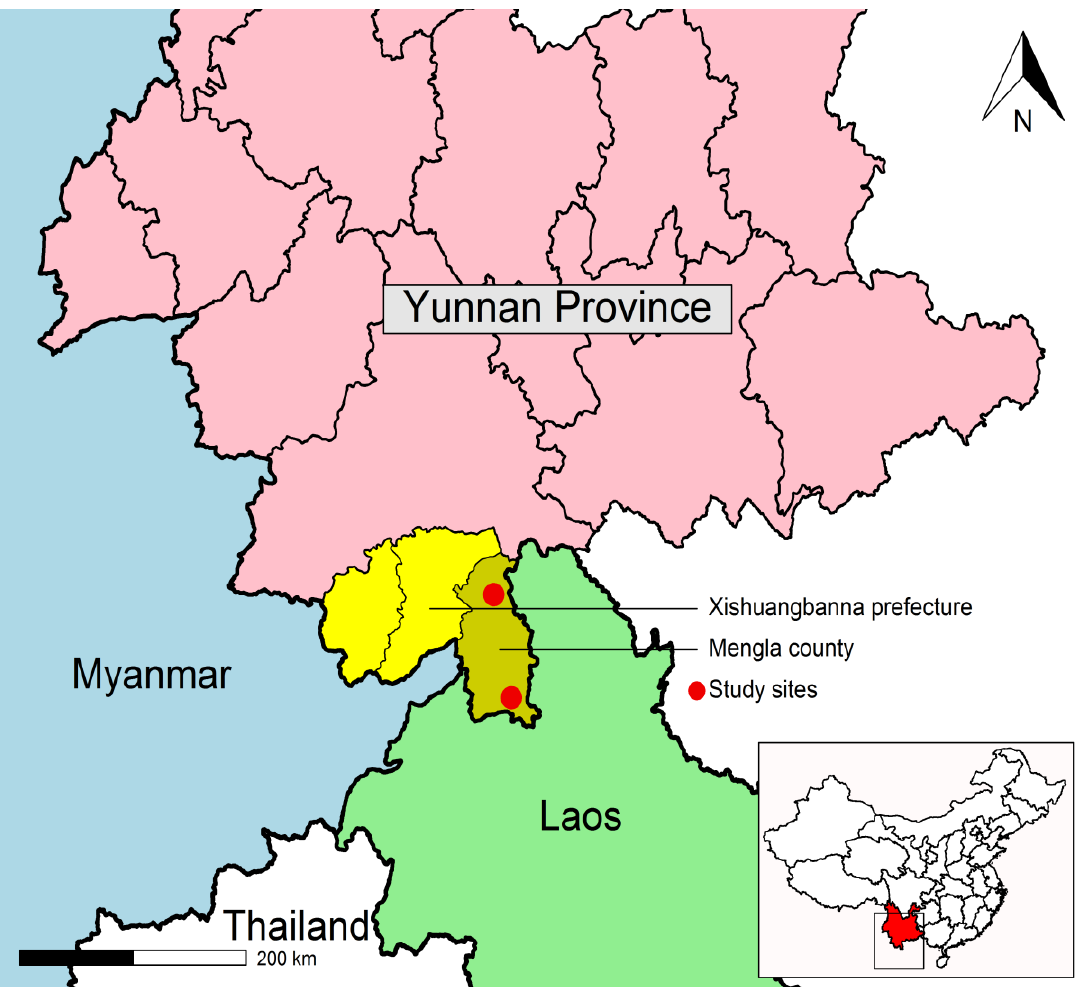
Figure 1. Map of study sites.